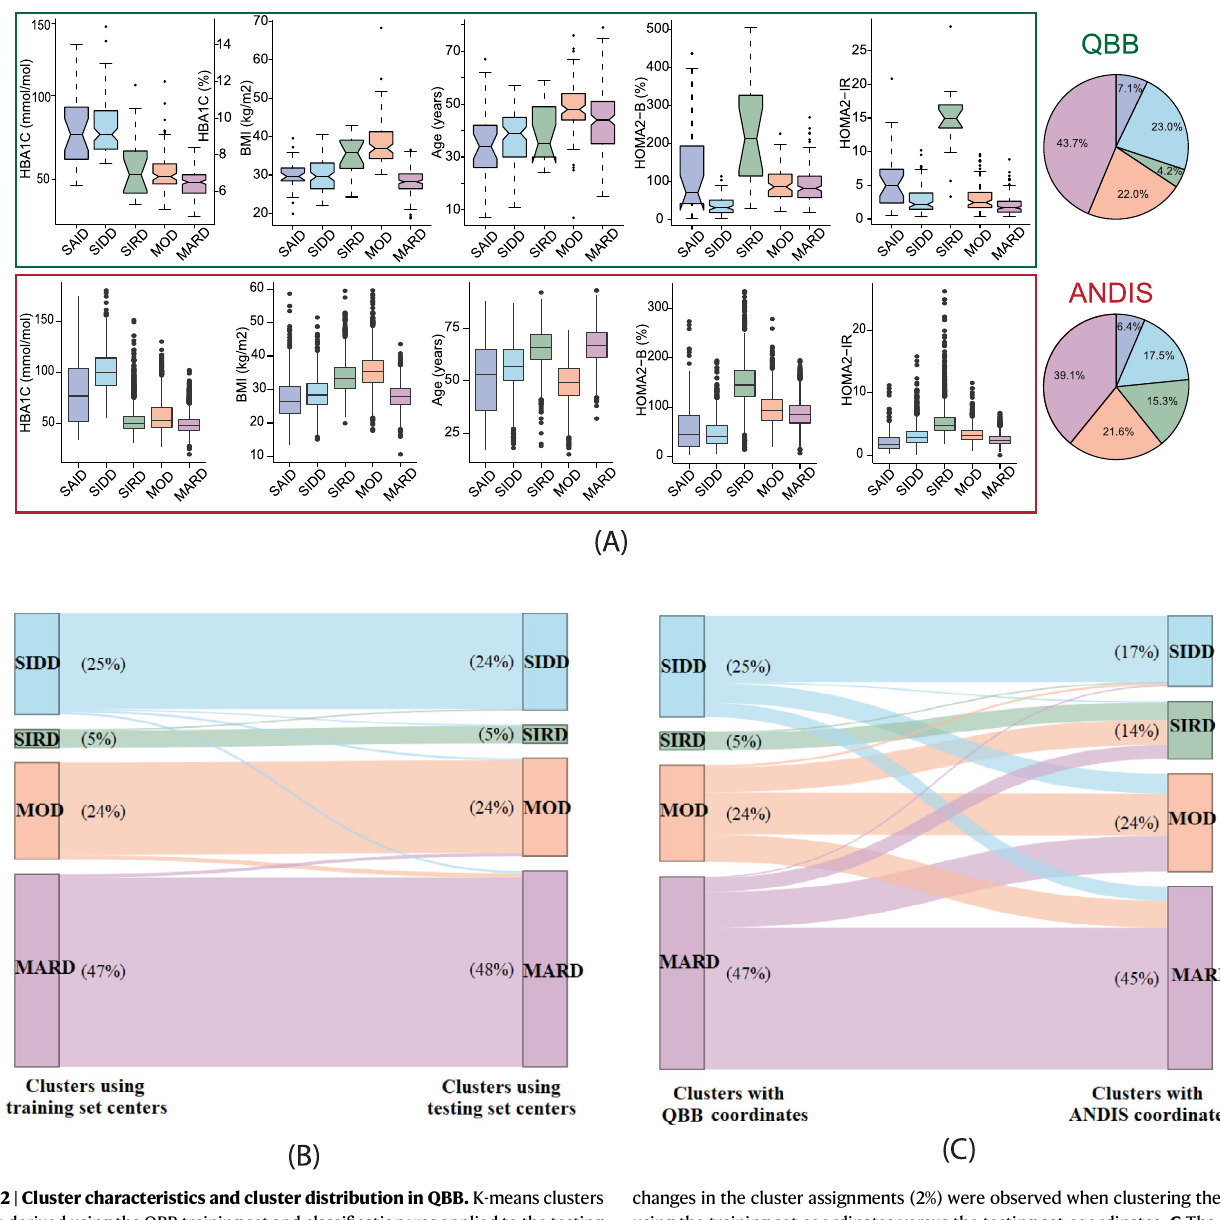
changes in the cluster assignments (2%) were observed when clustering the data using the training set coordinates versus the testing set coordinates. C The ANDIS coordinates were used instead of the QBB coordinates to classify QBB patients. Gender-speci fi